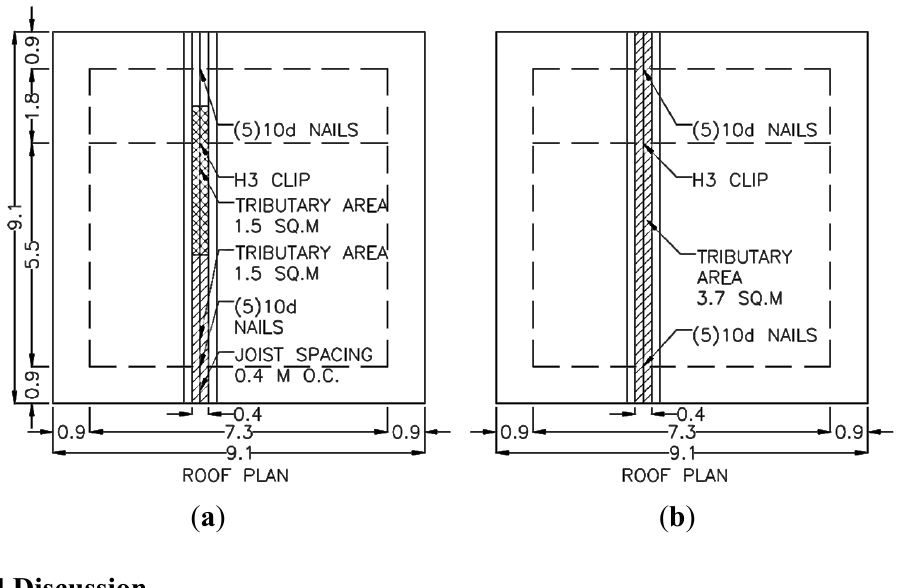
Figure 8. Loading conditions considered for fragility analysis ( a ) Individual case; ( b ) Combined case.